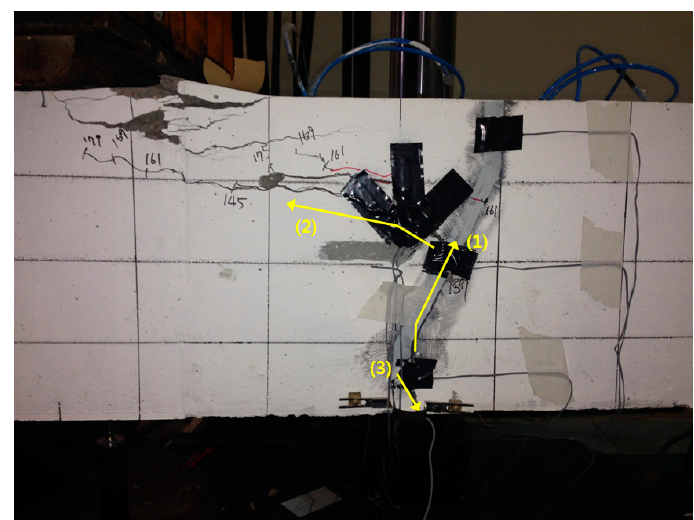
Figure 17. Crack pattern (EP): ( 1 ) Initial crack formation on the interface at 100 kN; ( 2 ) Crack propagation on left side at 140 kN; ( 3 ) Crack propagation on interface bottom at 165 kN. Table 11. Structural bond performance test results of MSAE.